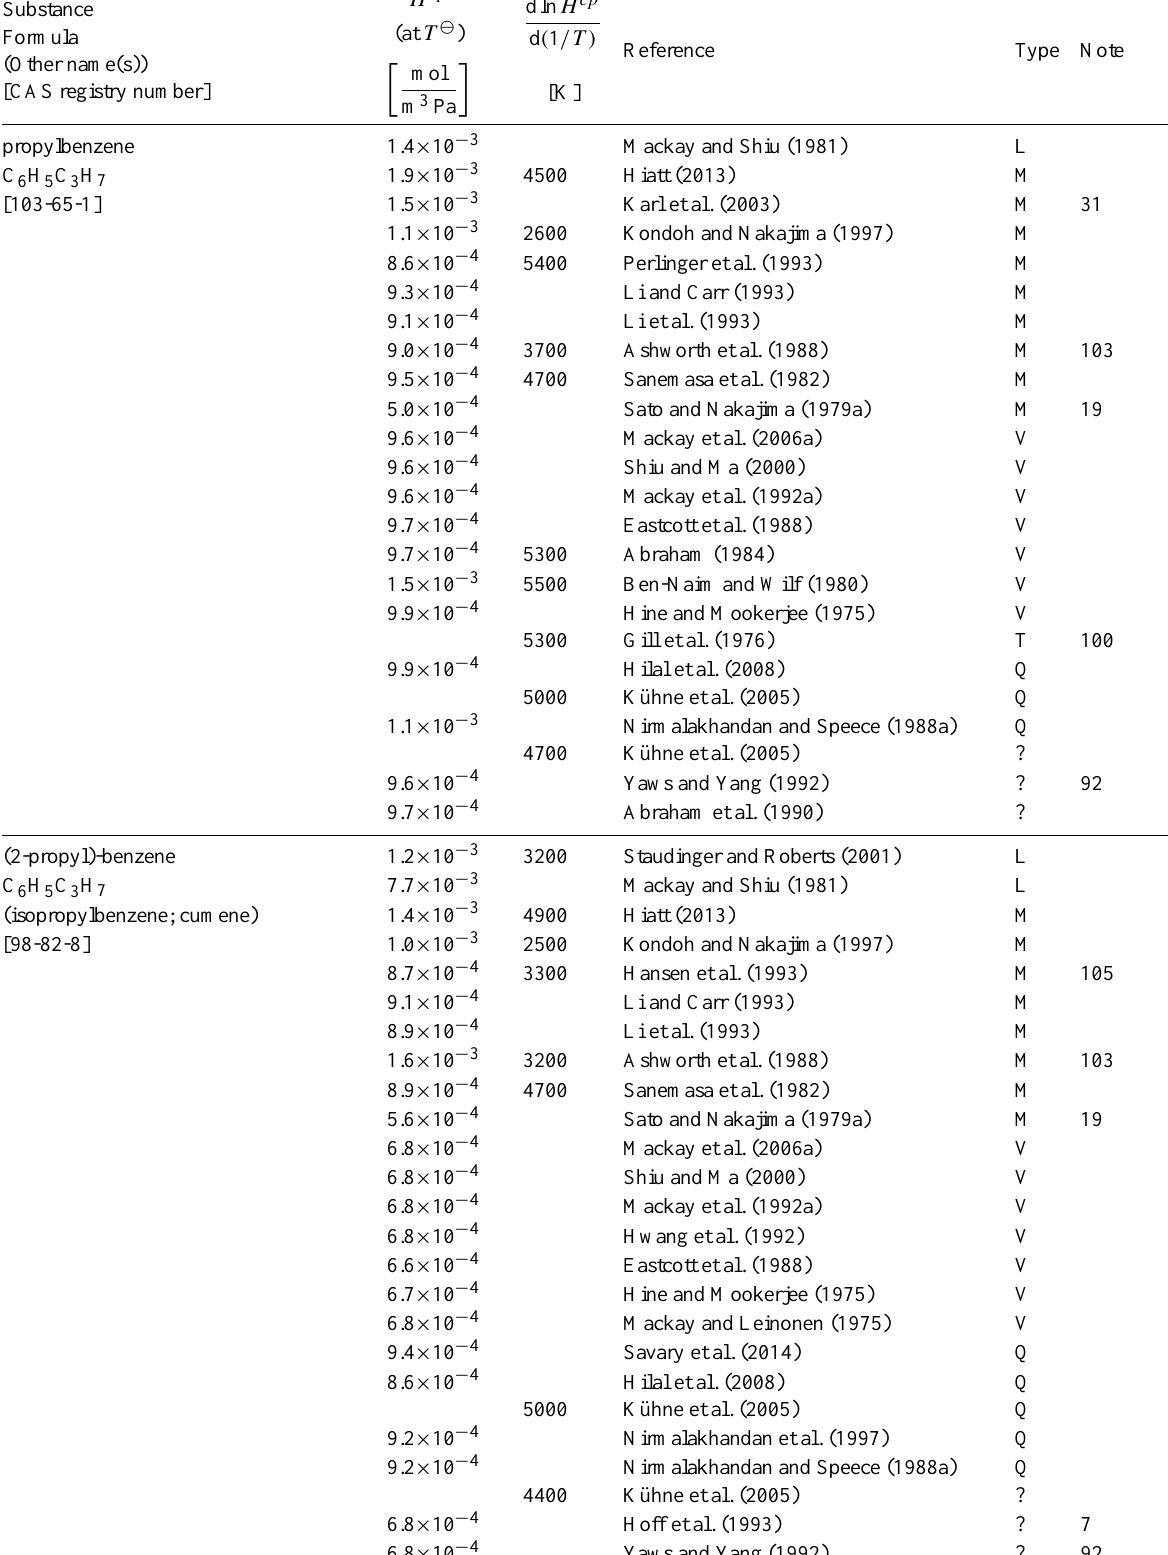
Table 6: Henry’s law constants for water as solvent